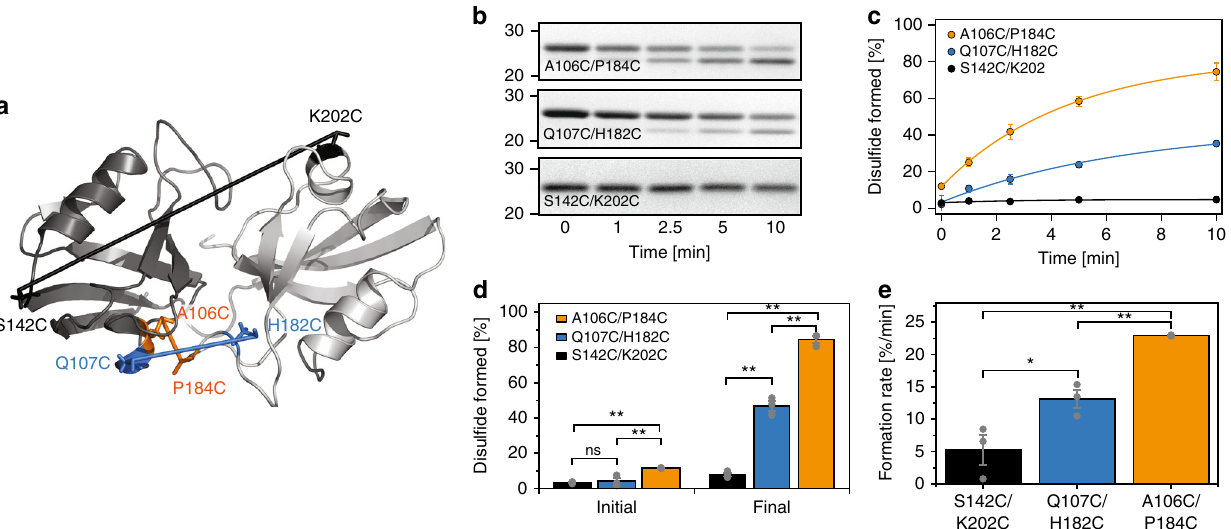
Fig. 5 Disul fi de mapping of the interdomain contact interface in the PDZ tandem. a Location of the engineered cysteine pairs used to test the contact interface. Cartoon representation of the CL state of the PDZ tandem. PDZ1, gray. PDZ2, white. Cysteine side chains are shown as lines with the pairs connected by their sulfur atoms. A106C/P184C, orange. Q107C/H182C, blue. S142C/K202C, black. b Representative SDS-PAGE showing individual time points in the disul fi de bond formation reaction used for the analysis. Disul fi de formation was initiated by shifting the samples to oxidizing conditions. The location of the introduced cysteine residues for each mutant is shown within each panel. Duration of the reaction for each time point is indicated below. The full gels are shown in Supplementary Fig. 11. c Kinetic analysis of the disul fi de formation reactions. A106C/P184C, orange. Q107C/H182C, blue. S142C/ K202C, black. Gel band intensities were measured in triplicate to obtain the percentage of disul fi de for each time point. Each time course was fi t with an exponential function to obtain the initial and fi nal percentage of disul fi de bonding along with the rate of disul fi de formation. d Extent of disul fi de formation for each mutant taken from the fi ts to panel B. The initial percentage (left) showed the presence of disul fi de before the oxidation reaction. The fi nal percentage showed the amount of disul fi de formed after the oxidation reaction has gone to completion. ** indicates p > 0.01; ns stands for no signi fi cance in an unpaired student t -test. e Disul fi de formation rate for each mutant as taken from the fi ts to panel b. ** indicates p > 0.002. * indicates p > 0.05 in an unpaired student t -test. For all graphs, error bars indicate SEM for three replicate measurements. Individual values are shown as